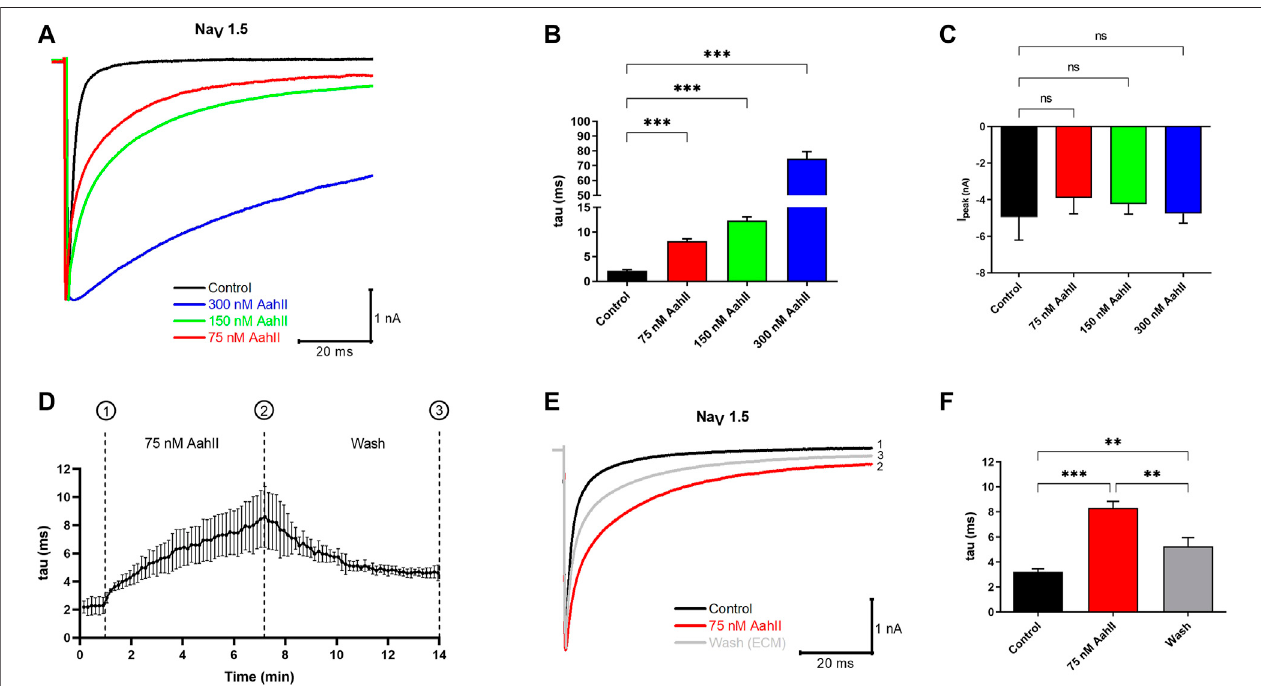
FIGURE1 | Thepharmacological effect ofAahII toxinon the Na V 1.5 channel overexpressed inHEK293cells. (A) Originalwhole-cellNa + currenttraces recorded in controlcondition(control=extracellularmedium=ECM)andinthepresenceofdifferentconcentrationsofAahIItoxin. (B) MeanofNa V 1.5inactivationtimeconstant(tau) inthecontrolconditionand followingapplicationofAahIItoxinatdifferentconcentrations(75, 150,and300 nM). Valuesarethemeanof5independent experiments, n = 5.Alldataarepresentedasmean±standarderror( ***p < 0.001). (C) Meanofcurrentamplitude,Ipeak(nA)measuredat − 40 mVinthesameconditionsasinpanel (B) .Valuesarerepresentativeofindependentexperiments, n =5.Alldataarepresentedasmean±SE( ***p < 0.001). (D) Meanofthekineticsofinactivationtimeconstant of the Na V 1.5 channel (tau) following perfusion of AahII toxin at 75 nM from 1 to 7 min followed by washing with ECM up to 14 min. Traces are representative of independent experiments, n = 3. All data are presented as mean ± SE. (E) Representative of original whole-cell current traces showing the reversible effect of AahII observed inpanel (D) .Trace1:current trace recordedin control medium, Trace 2: currentobtained at 7 min represents themaximum effectofAahIItoxin at 75 nM,and Trace3:current trace after washing theAahIItoxinduring 14 min. Traces are representative ofindependent experiments, n =3. (F) Meanofinactivation time constantof the Na V 1.5 channel (tau) following a similar protocol as in panel (D)